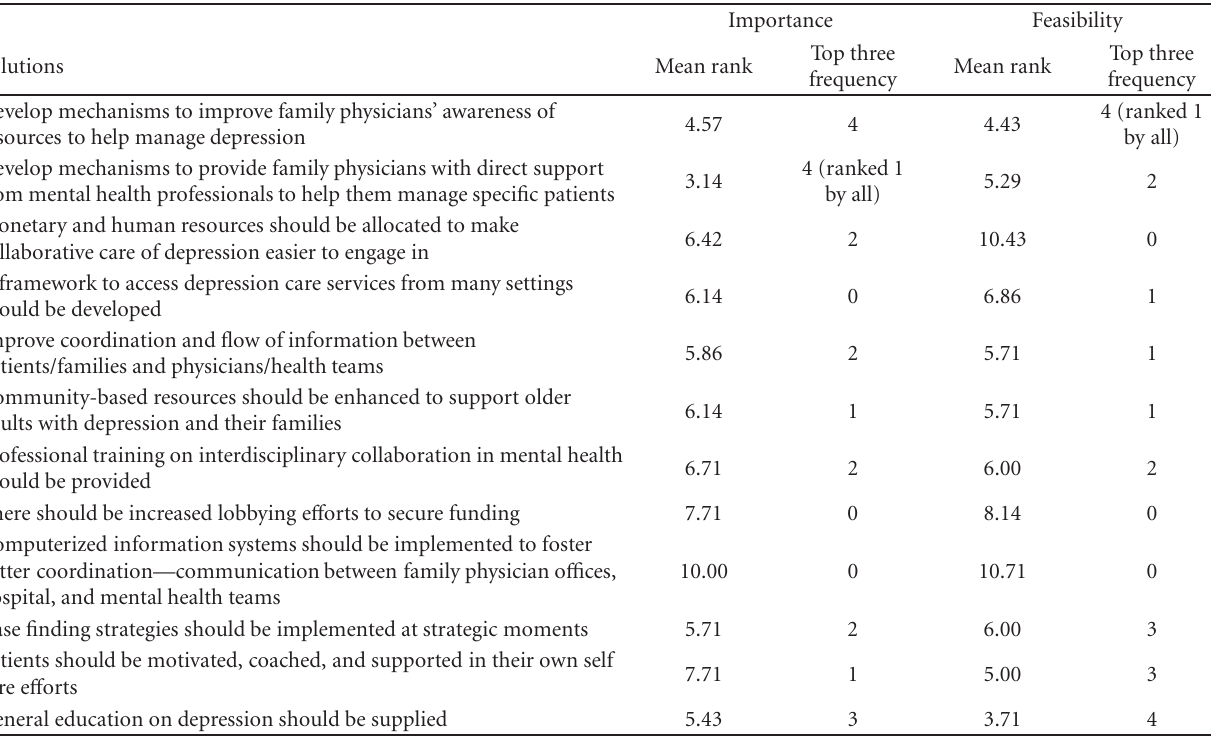
Table 2: Mean and frequency rankings of important and feasible solutions to depression management ranked by post-conference participants ( N =